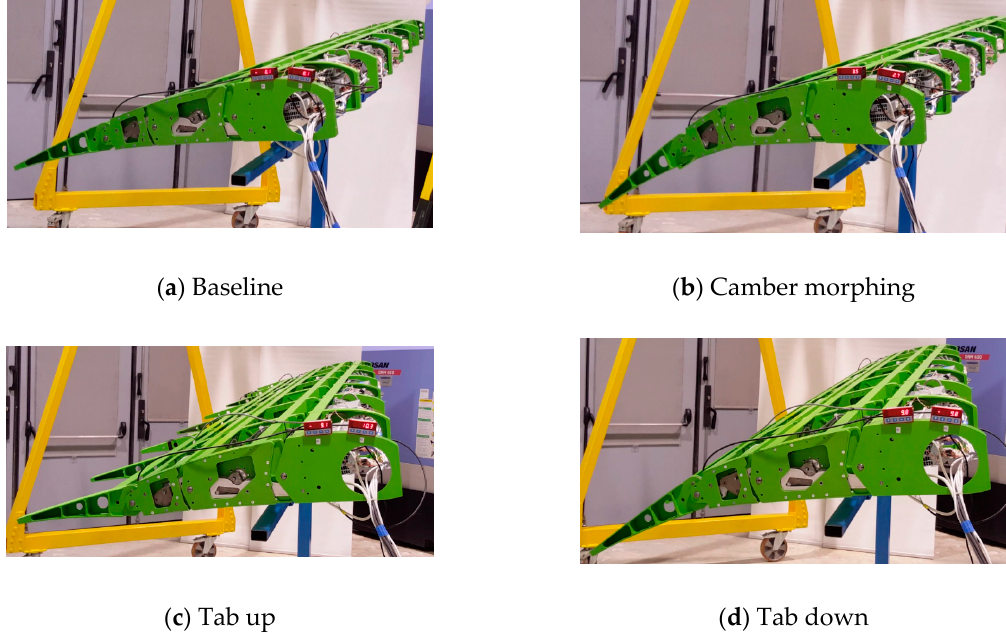
Figure 14. Flap configurations functionality test.